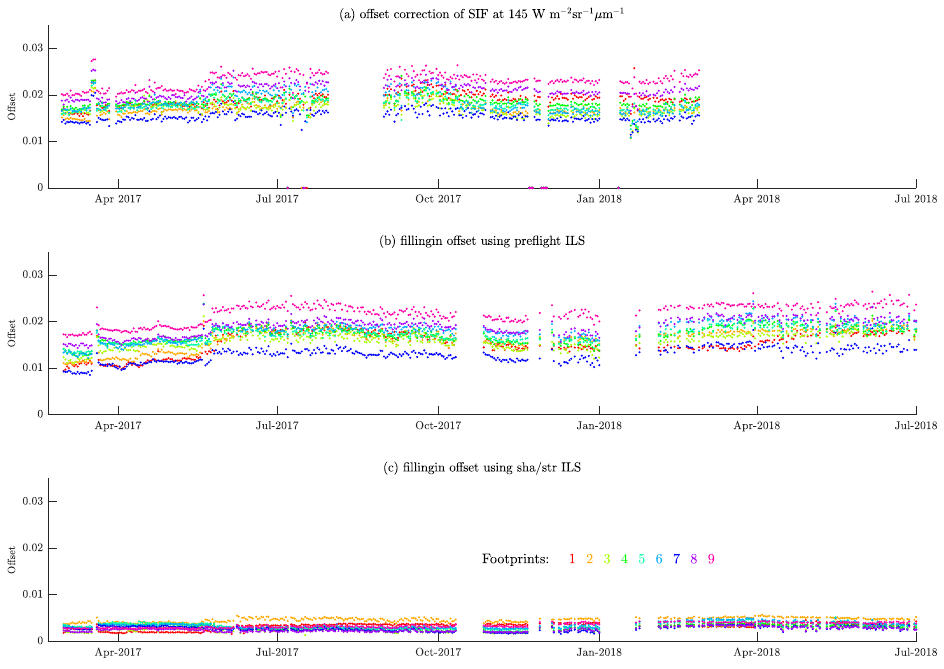
Figure 10. Time series of ( a ) SIF offset correction derived at 145 W m − 2 sr − 1 µ m − 1 . Filling-in offset derived using ( b ) preflight ILS and ( c ) stretch/sharpen ILS.